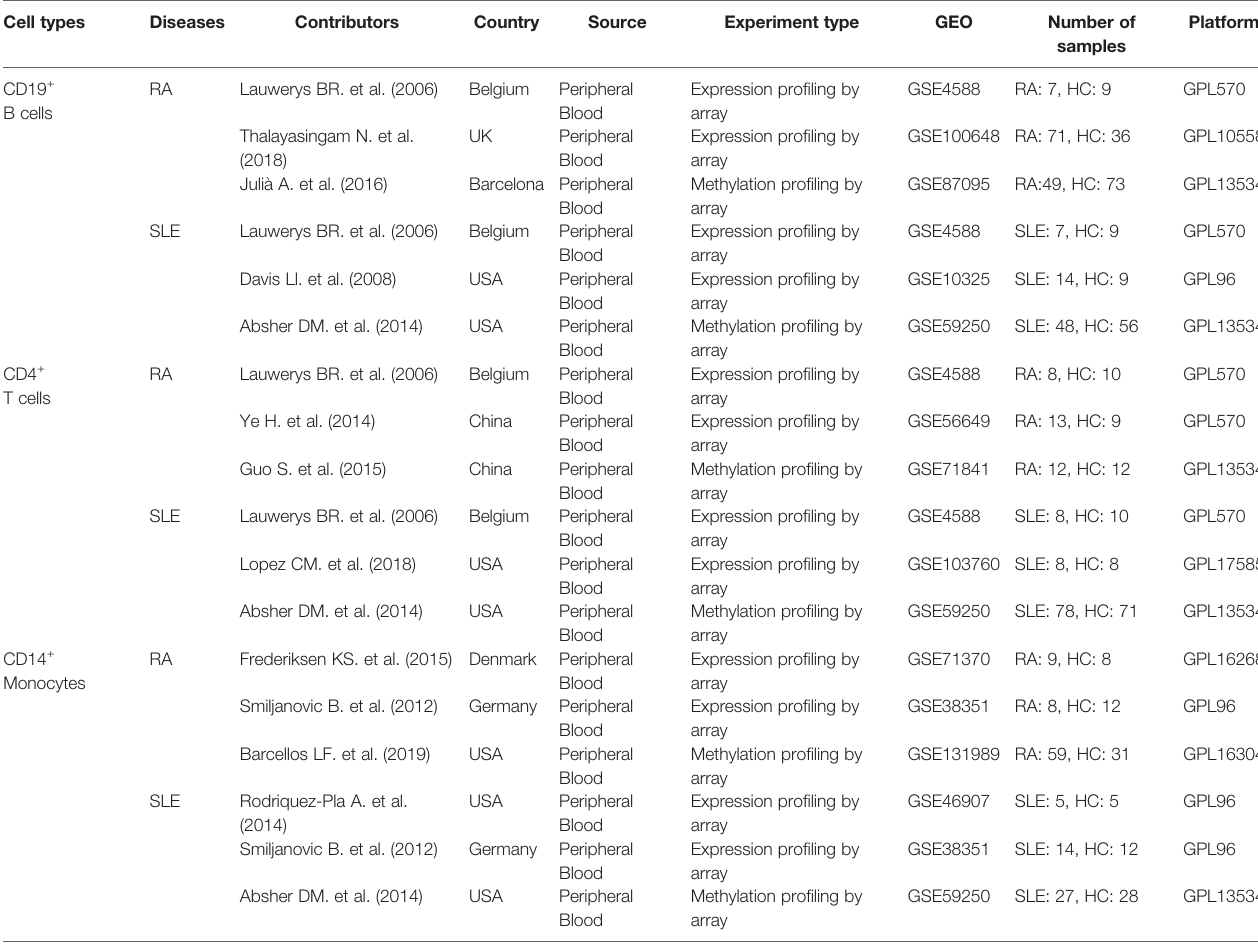
TABLE 1 | Details for GEO B cells, T cells and Monocytes data in RA and SLE.